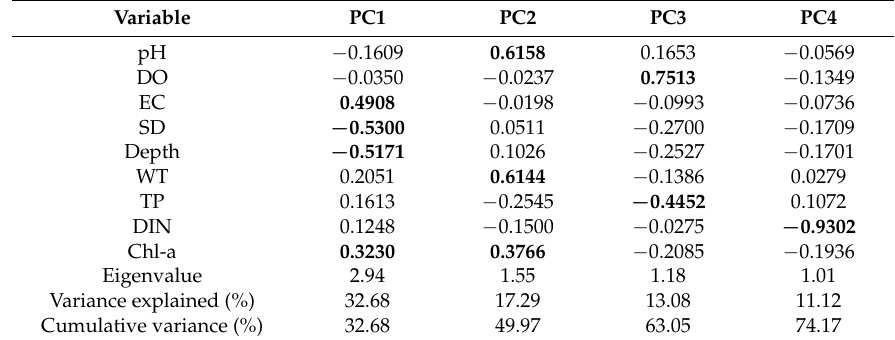
Table 2 . Principal components (PCs) percentage of variance, eigenvalues, and loadings for the examined environmental parameters.